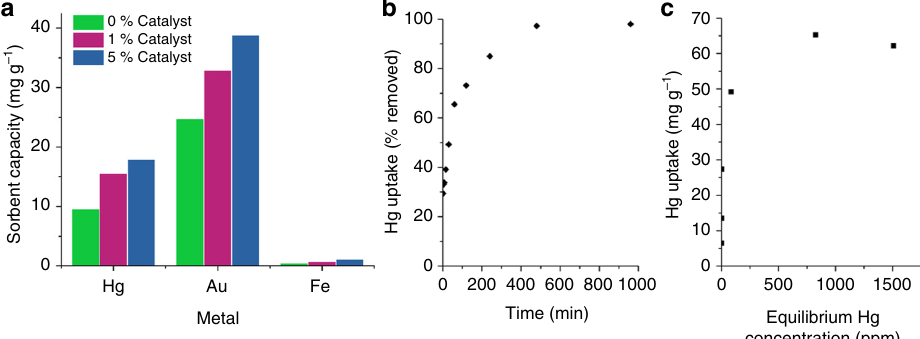
Fig. 3 Metal uptake by thiopolymers. a Uptake of metal by sulfur-limonene coated silica gel from 400 ppm aqueous solution of mercury chloride and iron chloride, and 800 ppm gold chloride, with varying Zn(DTC) 2 catalyst loading, after 1 h. b The uptake of Hg from 1000 ppm HgCl 2 aqueous solution, by 5 wt % Zn(DTC) 2 catalyzed sulfur-limonene coated silica gel, as a function of time. c The uptake of Hg, by 5 wt% Zn(DTC) 2 catalyzed sulfur-limonene coated silica gel, as a function of equilibrium concentration, to determine maximum